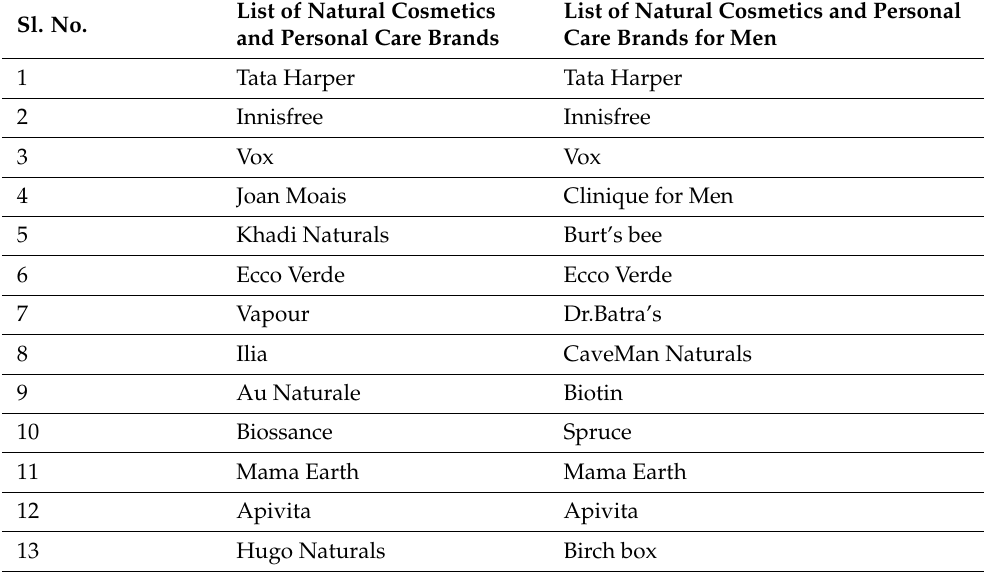
Table 1. List of natural cosmetics and personal care brands in India. Sl.